Question: Write a single sentence explaining what this figure depicts.
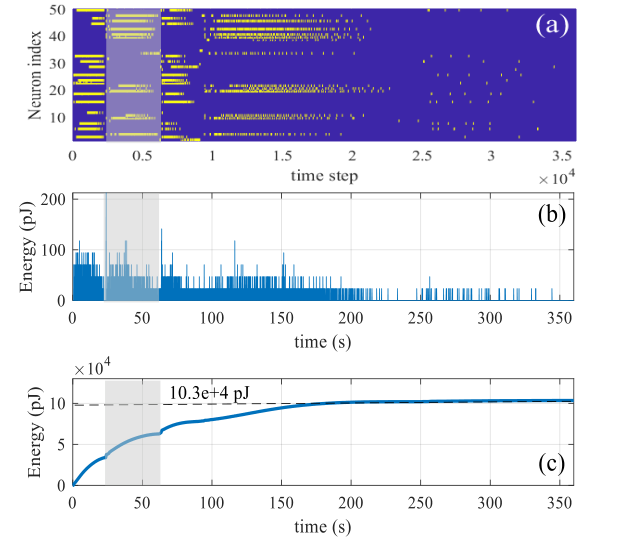
Answer: (a) displays the spiking pattern of the SNN in  response to the obstacle encounter scenario. The spiking  pattern clearly changes as the system enters the obstacle  interaction zone, reflecting SNN’s adaptation to the sudden  shifts in control inputs provided by the cloud. Upon exiting  the interaction area, the SNN reverts to a spiking pattern  similar to that observed in the obstacle-free scenario, as shown  in Figure 11(a).  This behavior underscores the event-driven  nature of SNNs, which are capable of adjusting their neural  activity in response to new conditions or significant changes